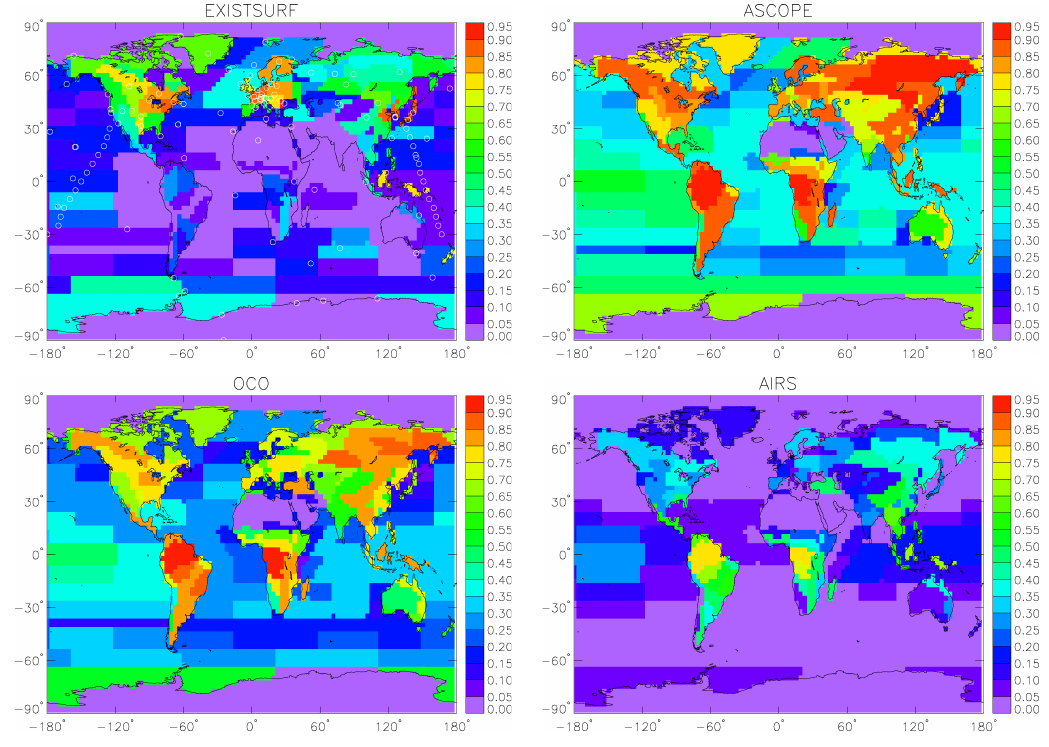
Fig. 4. Weekly mean error reduction for the (a) existing surface network (EXISTSURF) (b) A-SCOPE-2.0 (c) OCO (d) AIRS. White circles indicate the location of the surface stations.